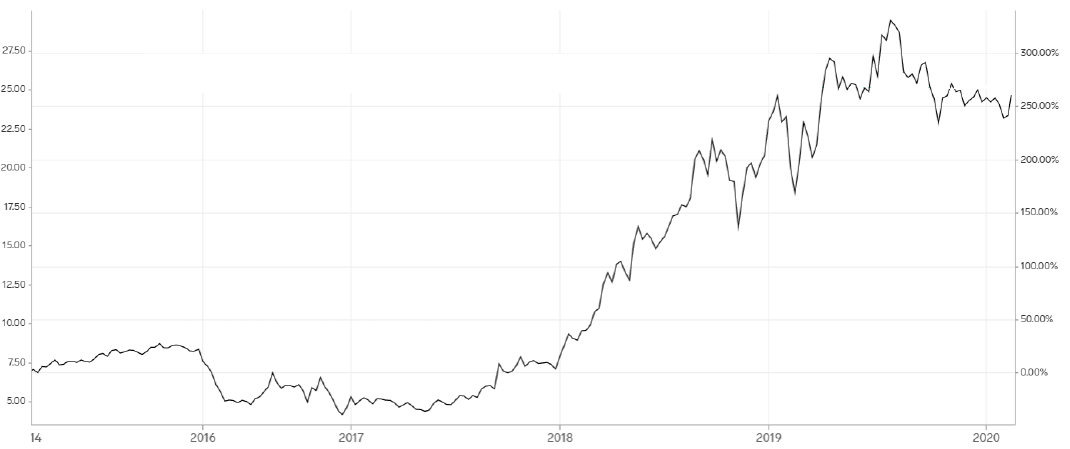
Figure 3. CO 2 European Emission Allowances ( e ), showing the evolution of prices during the last five years